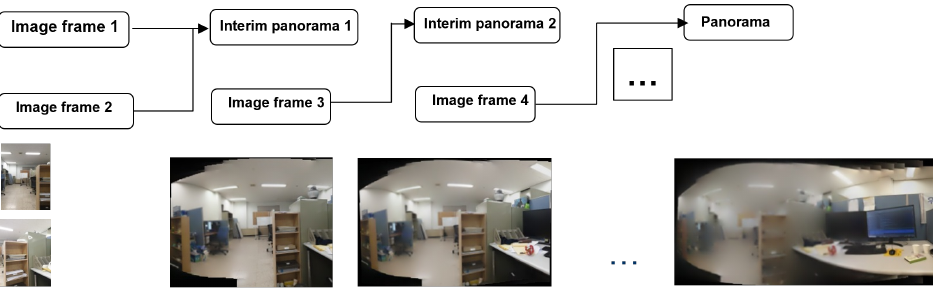
Figure 7. Distortion in the panorama when sequential stitching is performed.